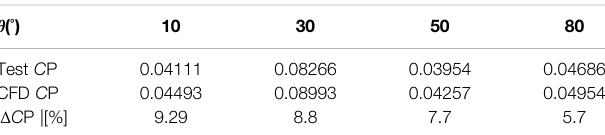
TABLE 1 | Validation of numerical